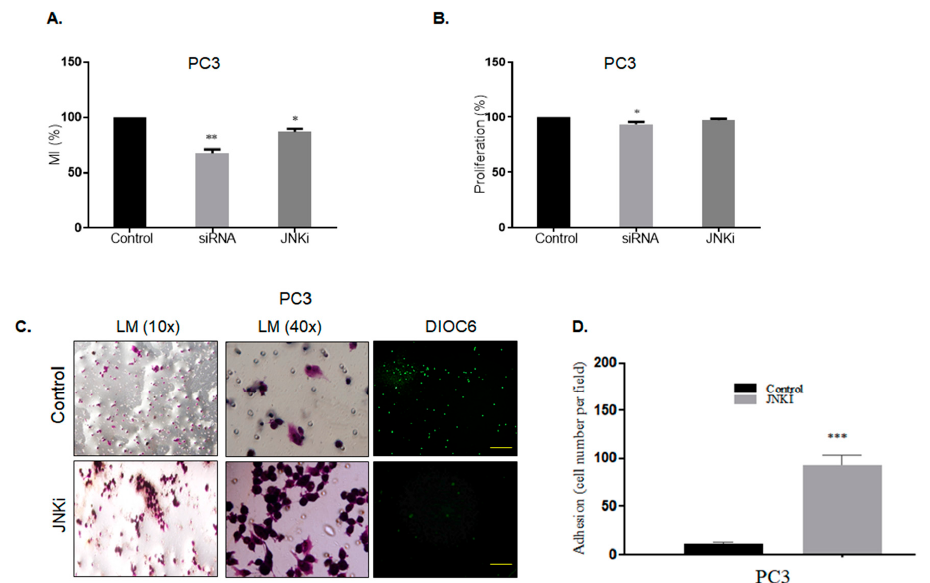
Figure 6. Effect of Wnt-11 silencing and JNKi on PCa cellular migration. ( A ) Motility index (MI) of PC-3 cells was evaluated by the transwell migration assay and presented as %. Migrated JNKi-treated PC-3 cells and Wnt-11-silenced PC-3 cells were counted (* p < 0.05; n = 3; ** p = 0.0026). ( B ) Proliferation assay was performed in JNKi-treated PC-3 cells and Wnt-11-silenced PC-3 cells ( n = 3; * p = 0.0486). ( C ) A Boyden chamber assay was performed following JNKi treatment in PC-3 cells. Unmigrated cells were visualized by crystal violet staining, and ( D ) cells were counted by fields that were randomly selected at × 10 magnification. Migrated cells were stained with DiOC6 and observed with fluorescence microscopy. The scale bar is 100 µ M; *** p = 0.002. Biology 2020 , 9 , 142